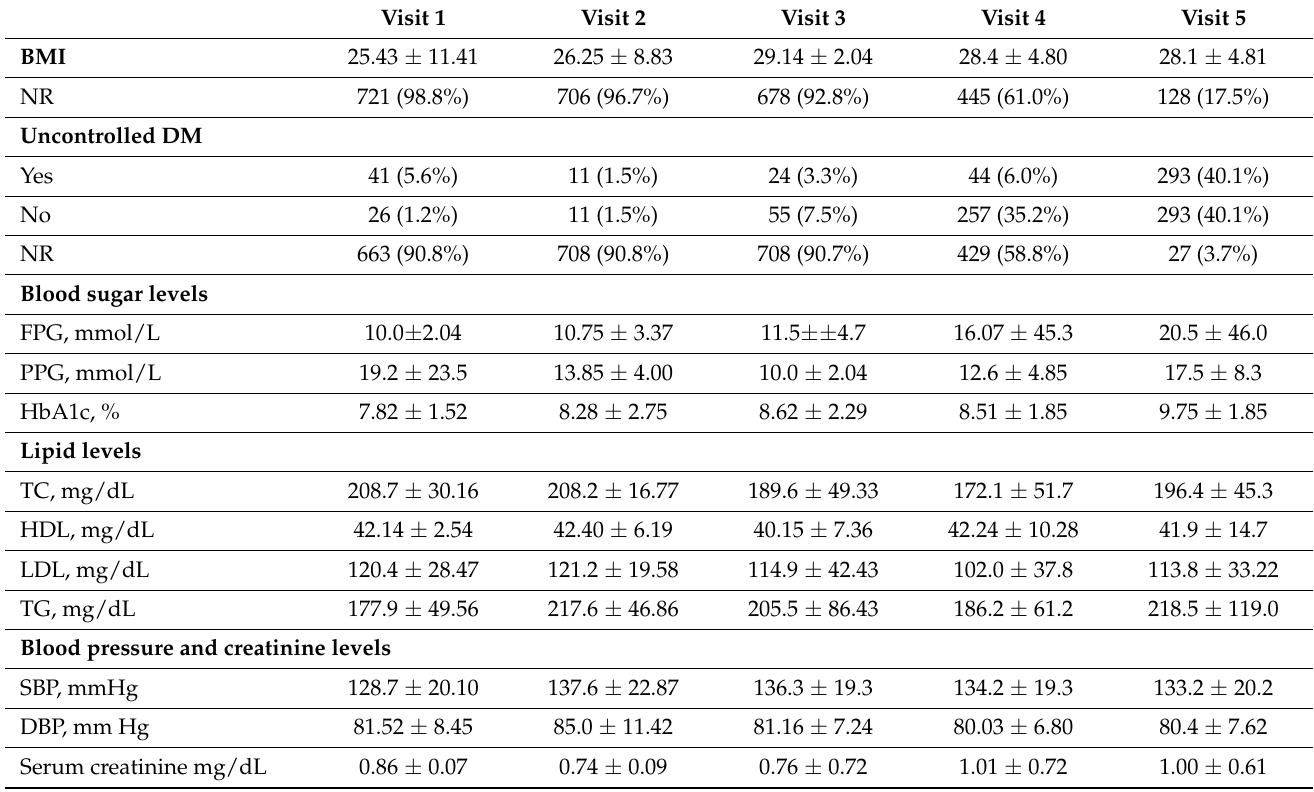
Table 3. Key clinical findings between December 2019 and November